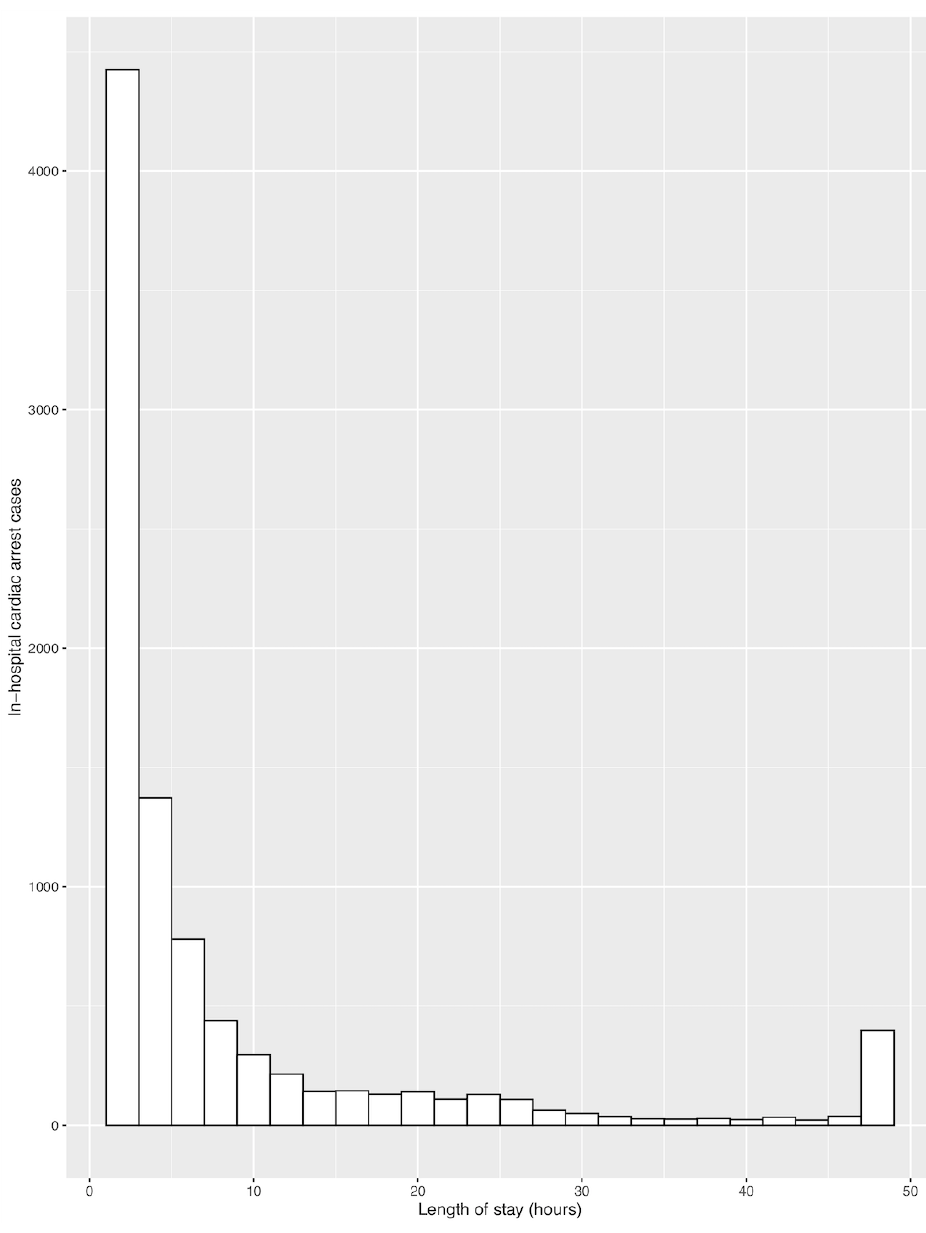
Figure 1. Relationship between in-hospital cardiac arrest and length of stay in the emergency department.